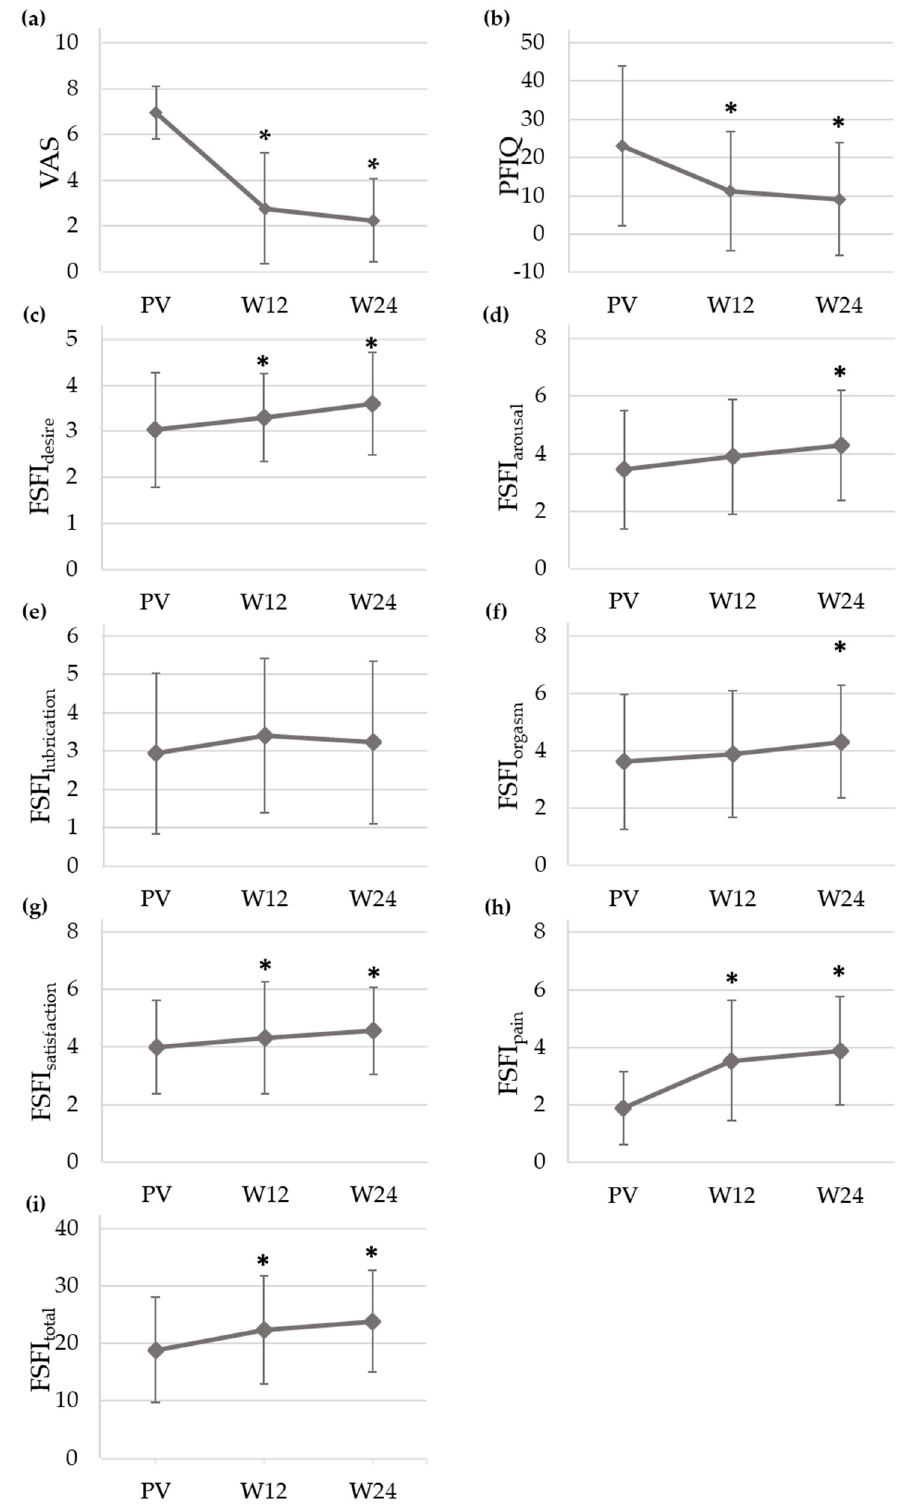
Figure 2. Mean and standard deviation of ( a ) Visual Analogue Scale (VAS), ( b ) Pelvic Floor Impact Questionnaire (PFIQ) and Female Sexual Function Index (FSFI) on ( c ) desire, ( d ) arousal, ( e ) lubrication, ( f ) orgasm, ( g ) satisfaction, ( h ) pain domains and ( i ) total score at the previous visit (PV) and at Weeks 12 (W24) and 24 (W24) of the study. (*): p value (Test 1) < 0.05.